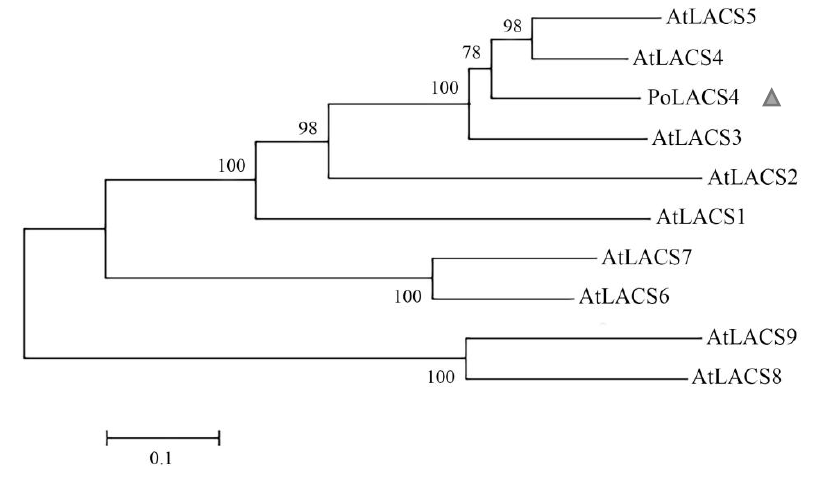
Figure 5. Phylogenetic analysis of PoLACS4 between ‘Feng Dan Bai’ and Arabidopsis thaliana .